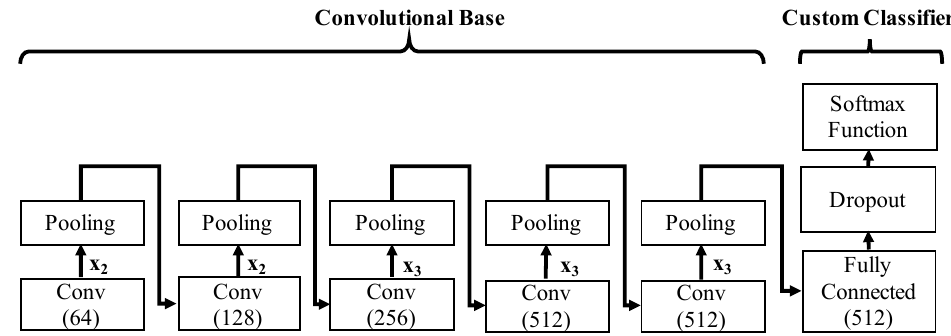
Figure 7. Architecture of the VGG16